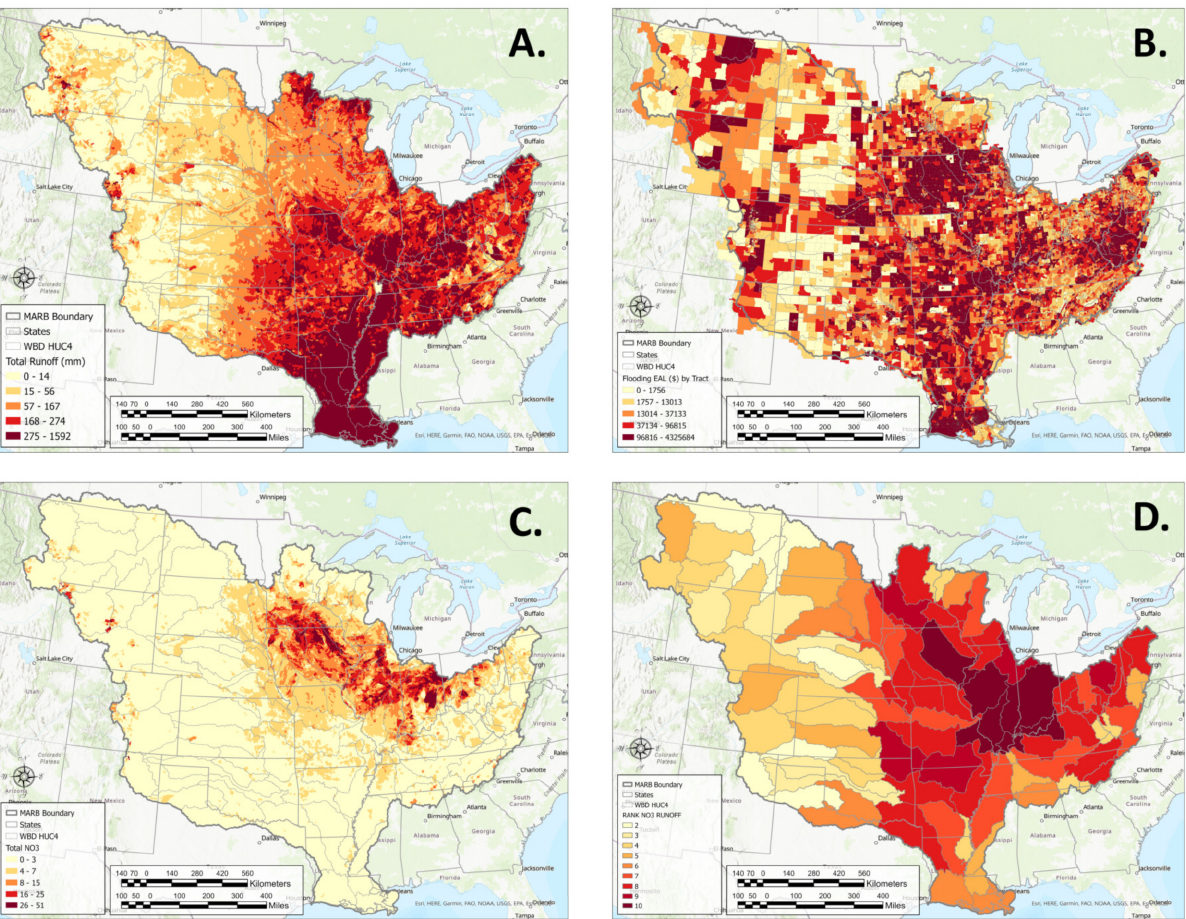
Figure 3. Spatial patterns of mean annual surface runoff by HUC12 obtained from the NAM ( A ), flood damages by census block ( B ), mean annual NO 3 -N loss by HUC12 obtained from the NAM ( C ) and combined risk to flooding and N loss by HUC4 ( D ) in the